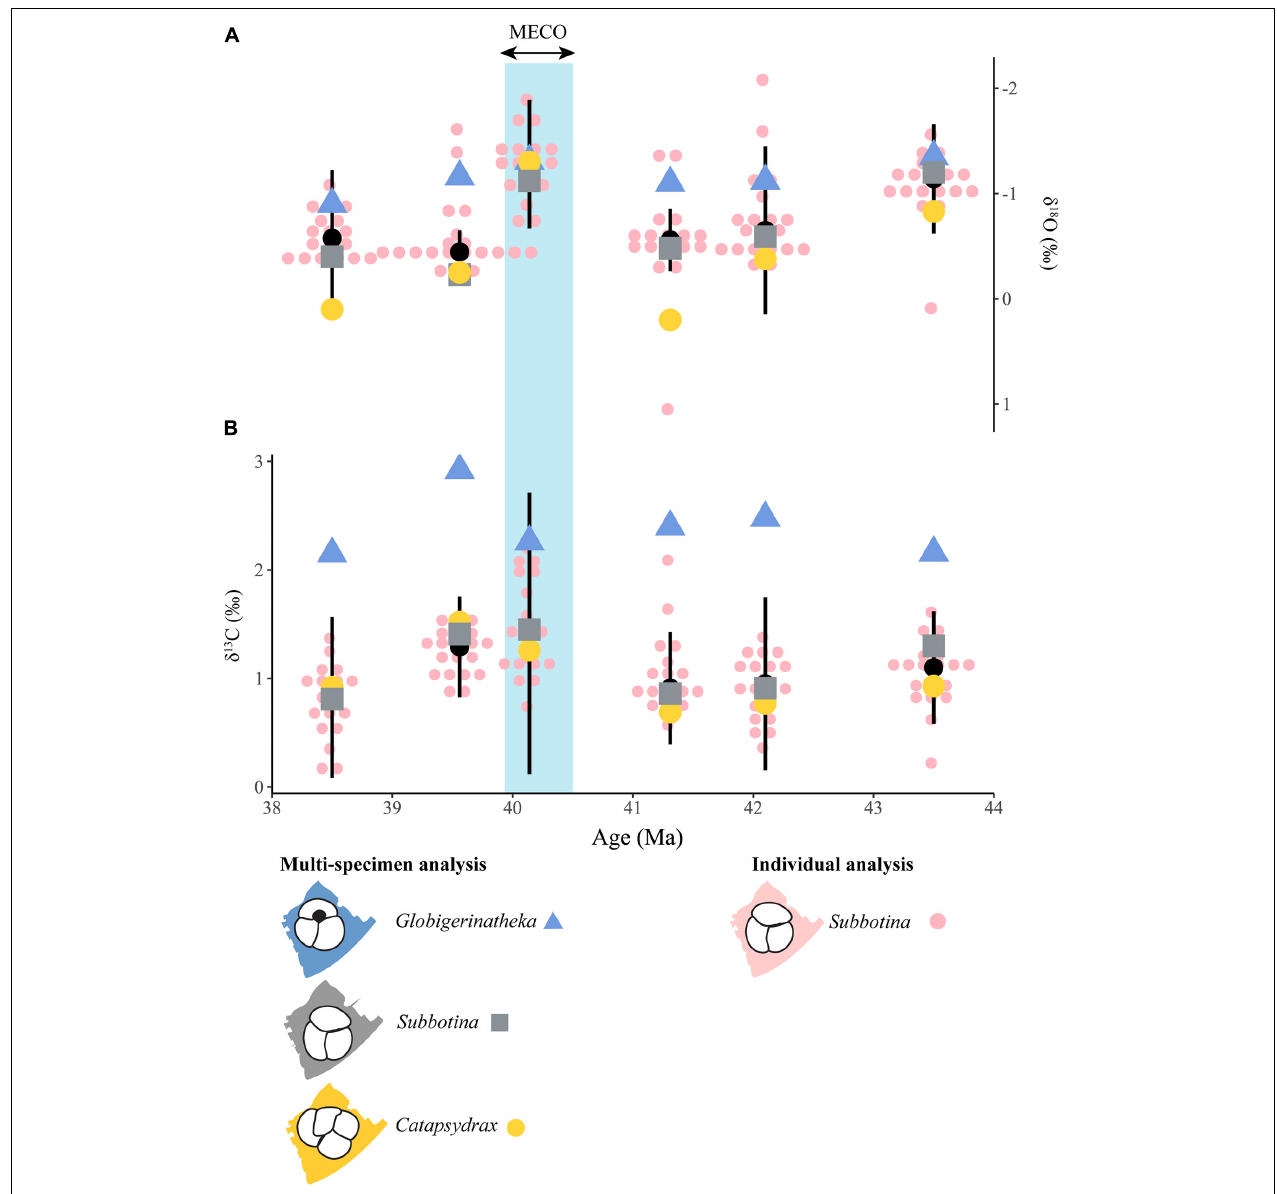
FIGURE 2 | Oxygen (A) and carbon (B) stable isotope results from individual foraminifera analysis (IFA) and batch multi-specimen analysis. Small pink circles show IFA of Subbotina , where circles are stacked horizontally multiple individuals have the same measurement. The genera used in batch analysis are represented by consistent coloring and shapes across each time slice: Globigerinatheka = blue triangles, Subbotina = gray squares and Catapsydrax = yellow circles. The black circle and vertical lines represent summary statistics from IFA with the circle representing the median and vertical line indicating 2.5 absolute standard deviations of the median (MAD). Note the reversed y- axis on panel A. The vertical blue box indicates the position of the